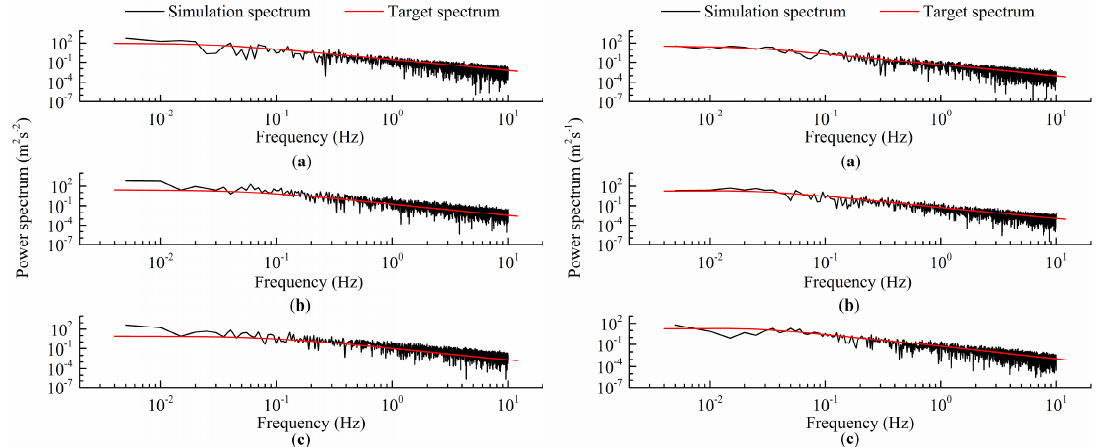
Figure 4. Comparison between the simulation spectrum and target spectrum of the fluctuating wind speed of hub height in LLJ inflow condition (left) and in shear inflow condition (right): ( a ) streamwise, ( b ) transverse, and ( c ) vertical components. The target spectrum was calculated from the wind speed spectral model, and the simulation spectrum was obtained from the simulated fluctuating wind speed.